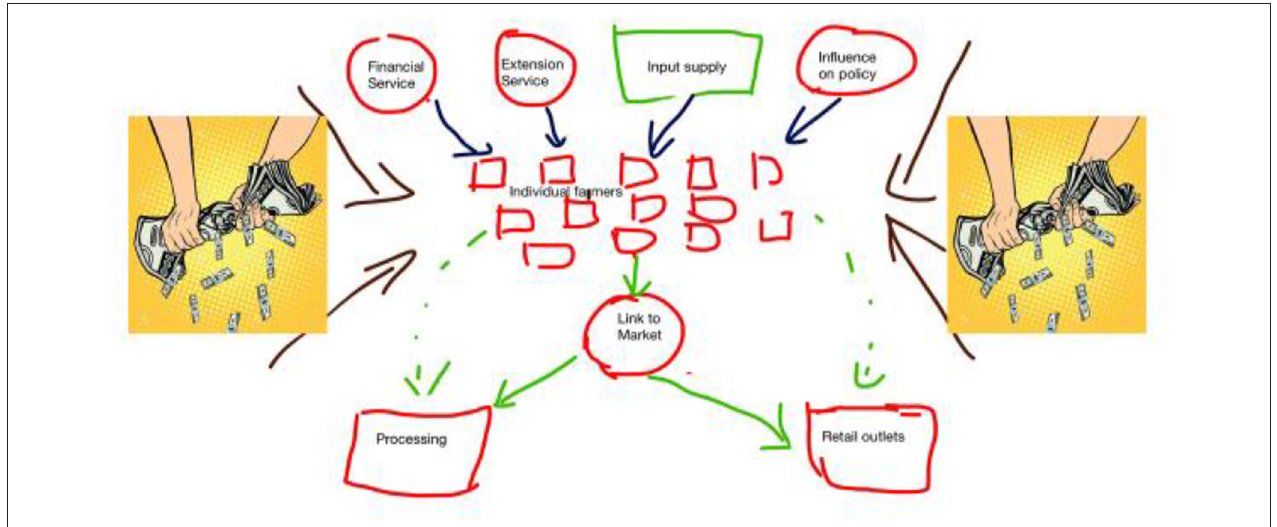
FIGURE 2 | Illustration of the squeezing pressure on smallholder farmers’ profit under fragmented production